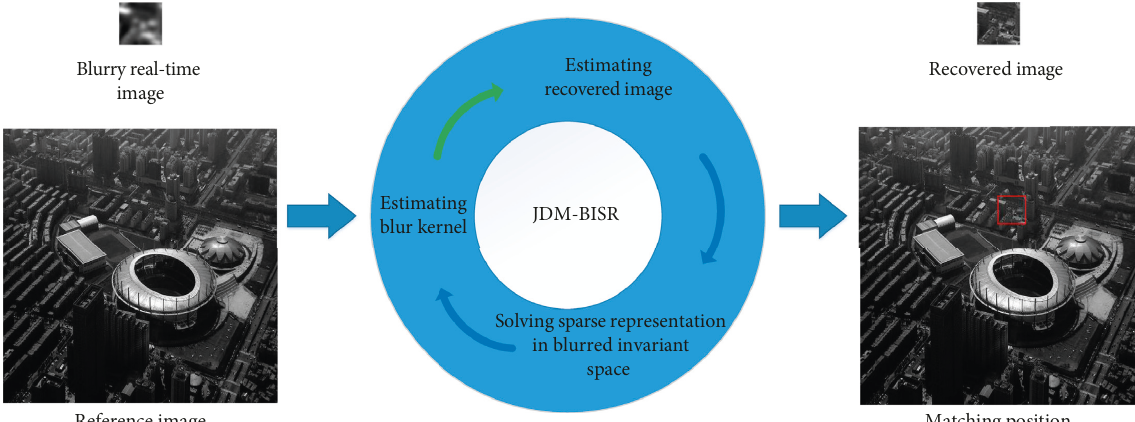
Figure 1: The framework of our joint image deblurring and matching method with blurred invariant-based sparse representation prior. Given a blurry real-time image, JDM-BISR iteratively recovers the clear image and locates the right position of the blurry image. The method will output the recovered image and the position in the reference